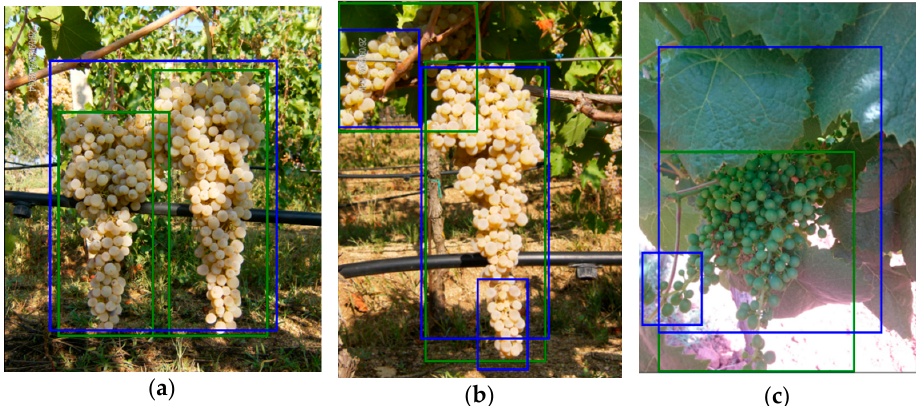
Figure 14. Examples of errors in the internal dataset. The green boxes represent the ground truth while the blues ones are the detection results. In ( a ) the incorrect detection of overlapping bunches, in ( b ) undetected shaded parts, and in ( c ) leaves incorrectly detected as bunches.